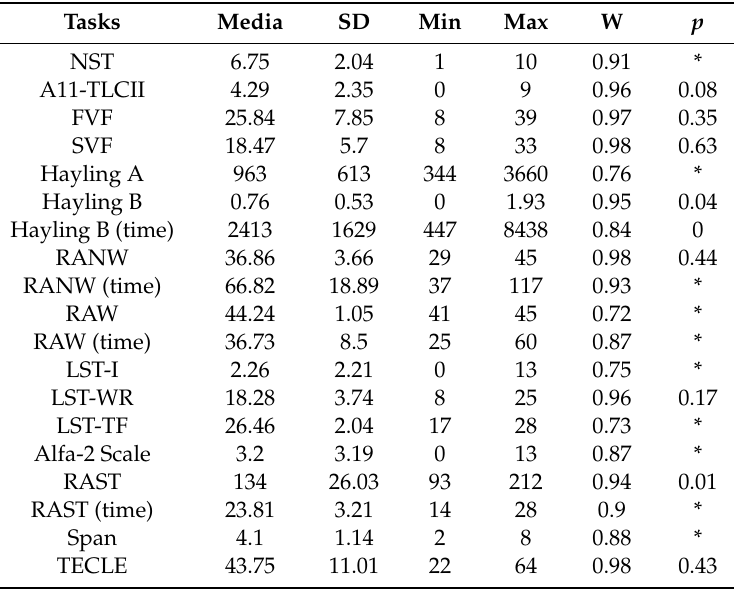
Table 1. Descriptive statistics and normality